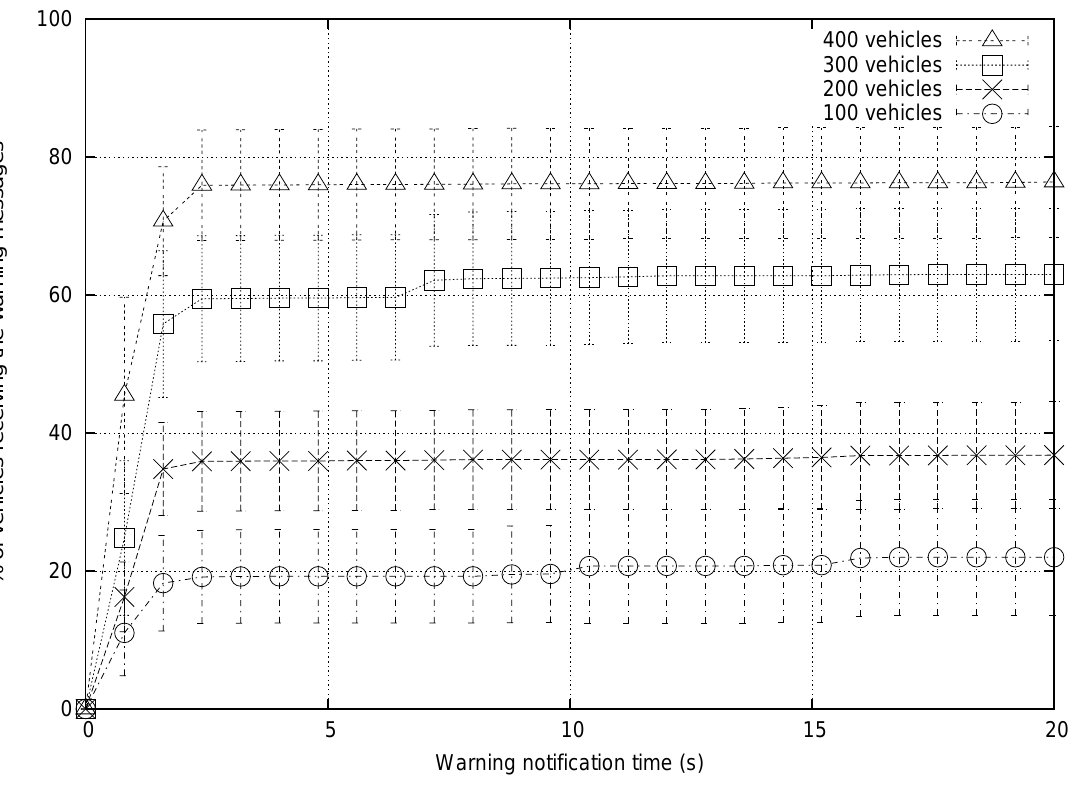
Figure 5. Warning notification time when varying the density of vehicles.